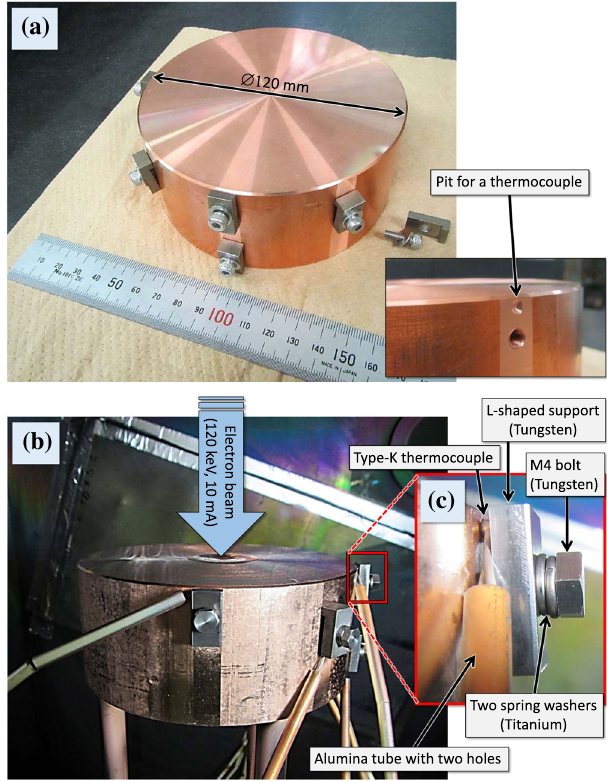
FIG. 11. Setup for the thermal radiation measurement. (a) Cop- per cylinder with a diameter and a thickness of 120 and 50 mm, respectively. (b) Setup in the EBW machine. (c) Magnified view around one of the